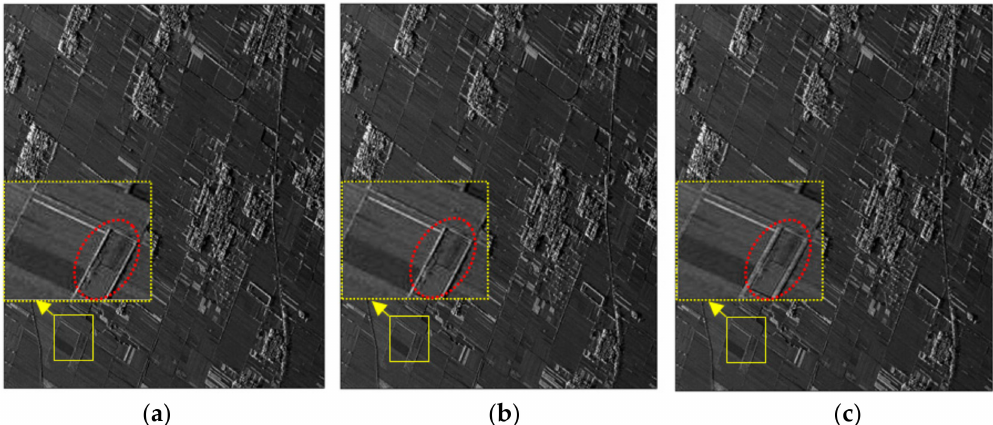
Figure 11. Scene simulation data results processed by different algorithms. ( a ) Scene simulation data results processed by traditional BPA. ( b ) Scene simulation data results processed by the EBP algorithm. ( c ) Scene simulation data results processed by the reference